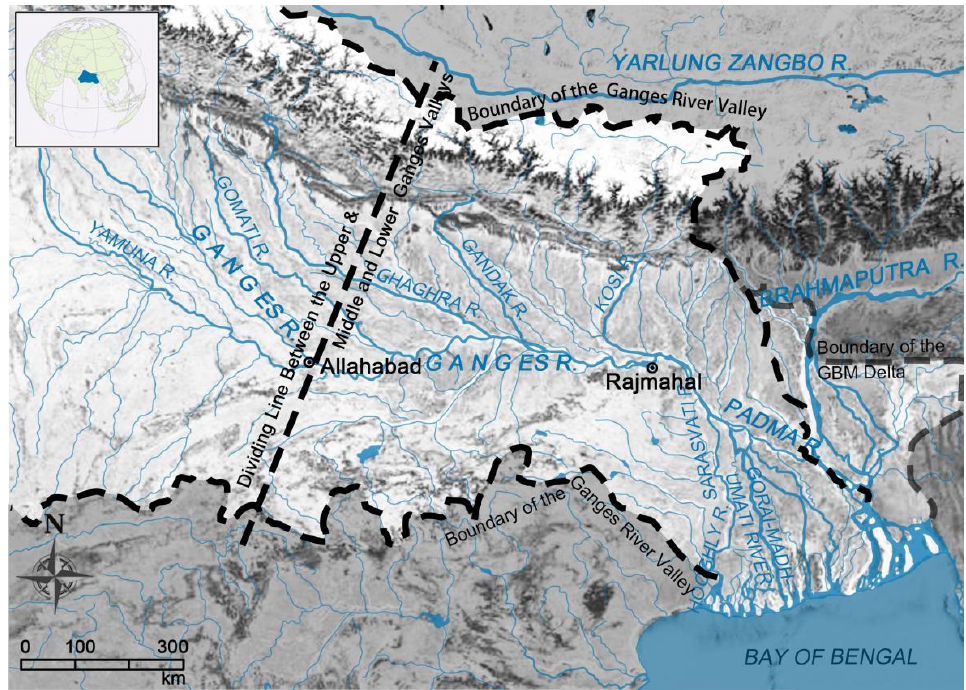
Figure 1. Schematic map of the Ganges River Valley and the GBM Delta. Source: the authors; Base Map: Google satellite map.